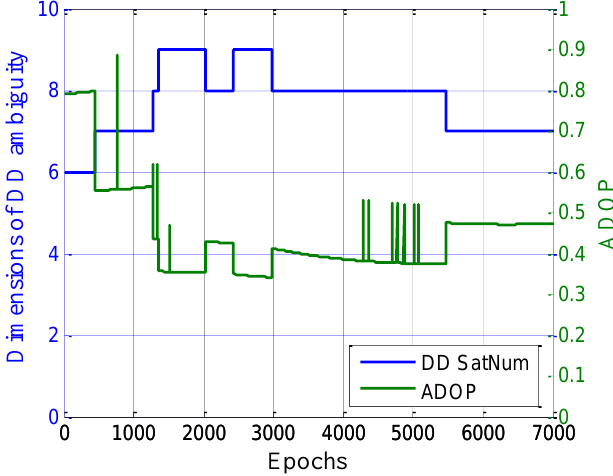
Figure 11. Visible DD satellite number and ADOP value.